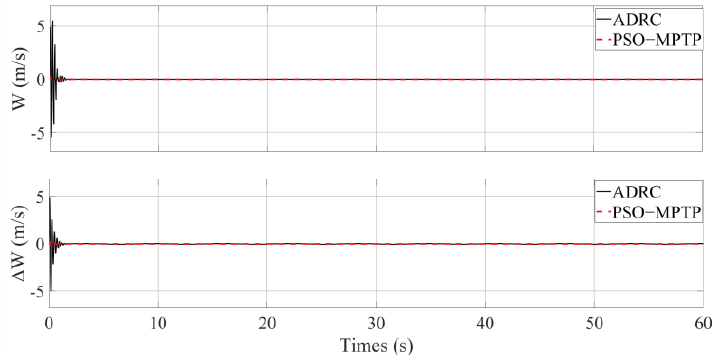
Figure 12. Control constraint and Control increment constraint of crane load, Case 2.